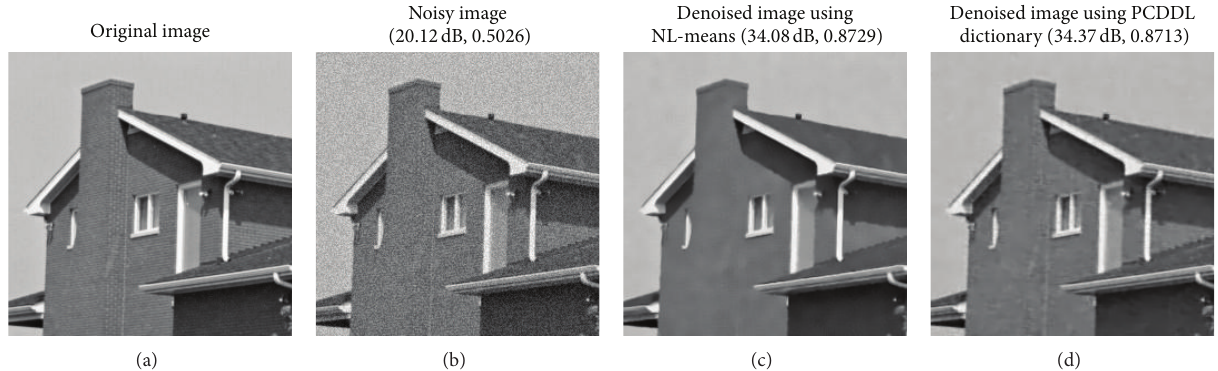
Figure 8: Example of the denoising results for the image “House” with the noise level of 20.12 dB. In brackets, the former items denote PSNR values, and the latter items denote the SSIM index.